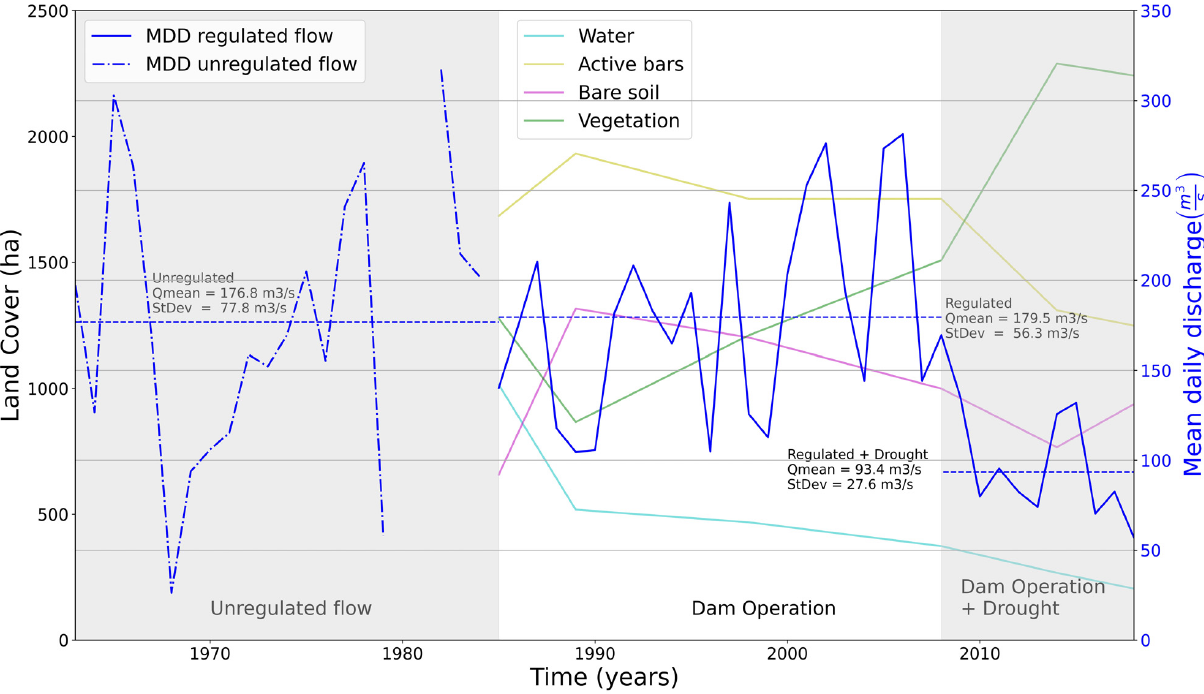
Figure 12. Combined land cover changes along with mean daily discharges during the entire studied period (unregulated + regulated + drought).